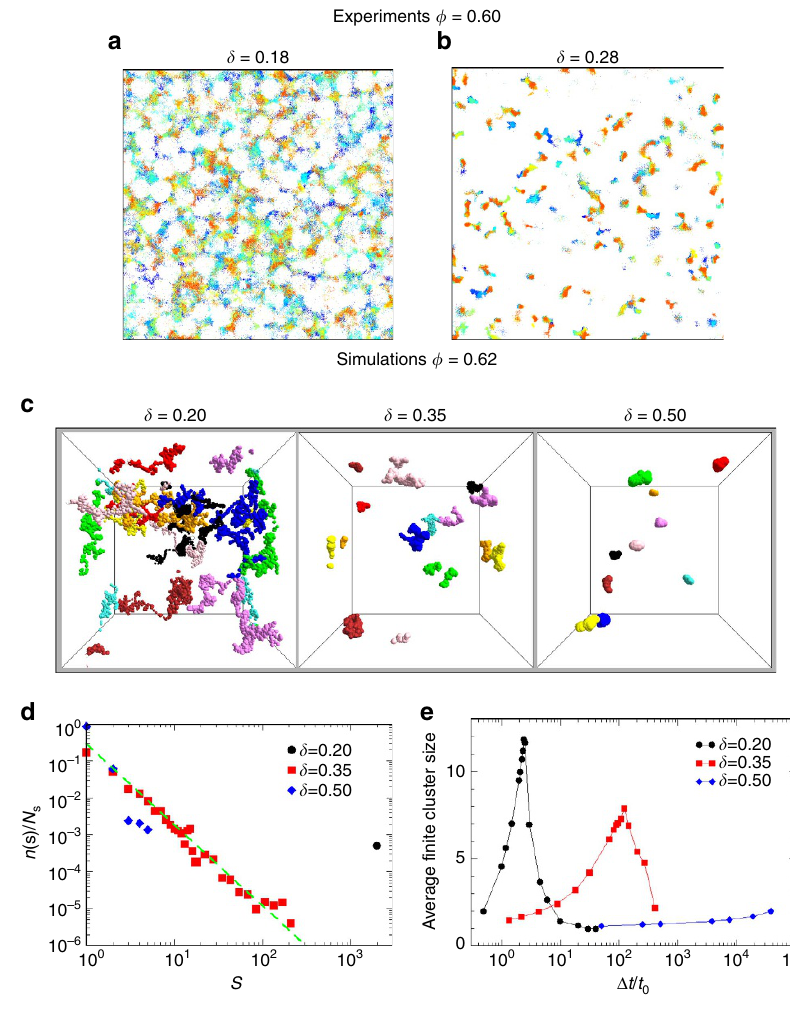
Figure 4 | Illustration of the space explored by small particles during their motions. ( a – b ) Overlay of small particle positions at different times (colour coded from blue, corresponding to t exp 0s to red, corresponding to t exp 297s with time steps of 33s), obtained by particle tracking applied to 2D i ¼ f ¼ confocal microscopy images, for f ¼ 0.60 and ( a ) d ¼ 0.18, ( b ) d ¼ 0.28. ( c ) Positions of 10 small particles (distinguished by different colours) for (left) 100 t 0 , comparable with the experiments ( d ). Distribution n ( s ) d ¼ 0.2, (middle) d ¼ 0.35 and (right) d ¼ 0.5, for a fixed total time of the trajectories t sim f ¼ (normalized by the number of small particles N s ) of the size s of clusters as defined in Methods, providing a measure of the space explored by small 100 t 0 . For d ¼ 0.35 data follow a power-law dependence n ( s ) B s (cid:3) 2.19 , consistent with random particles, evaluated within a fixed time interval t sim f ¼ percolation (dashed line), while for d ¼ 0.20 all particles belong to the same cluster. ( e ) Average size L c of finite clusters as a function of time, for different d , as indicated. The maximum in each curve signals the onset of